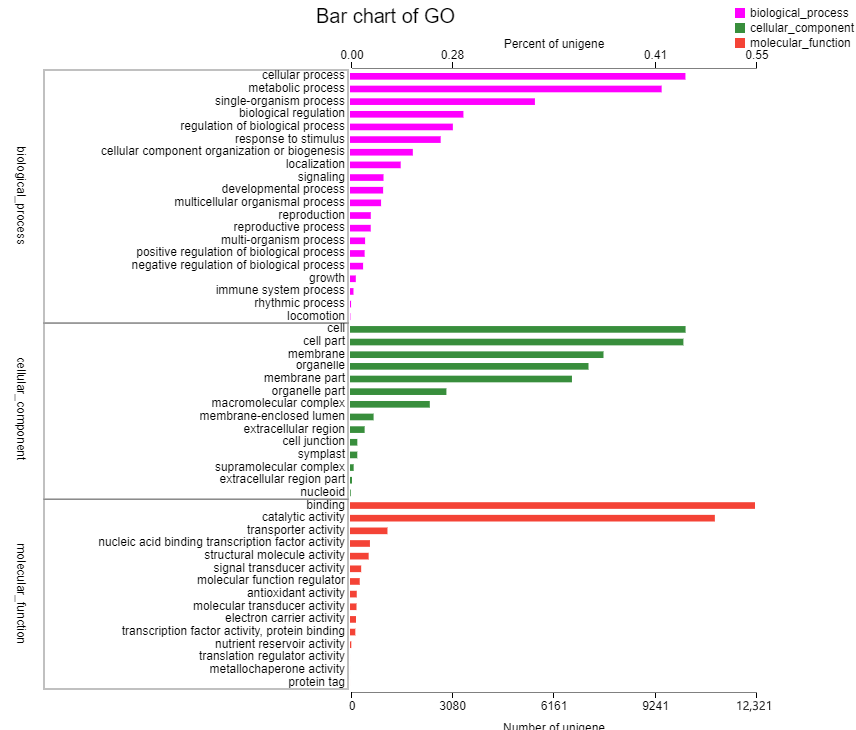
Figure 1. Gene Ontology (GO) function classification of the annotated unigenes in resistant Beckmannia syzigachne . The unigenes were allocated to three categories: biological process, cellular component, and molecular function. The unigenes sequence of resistant (R) B . syzigachne have been deposited in the NCBI Sequence Read Archive (SRA) database with accession number SRR21047671.